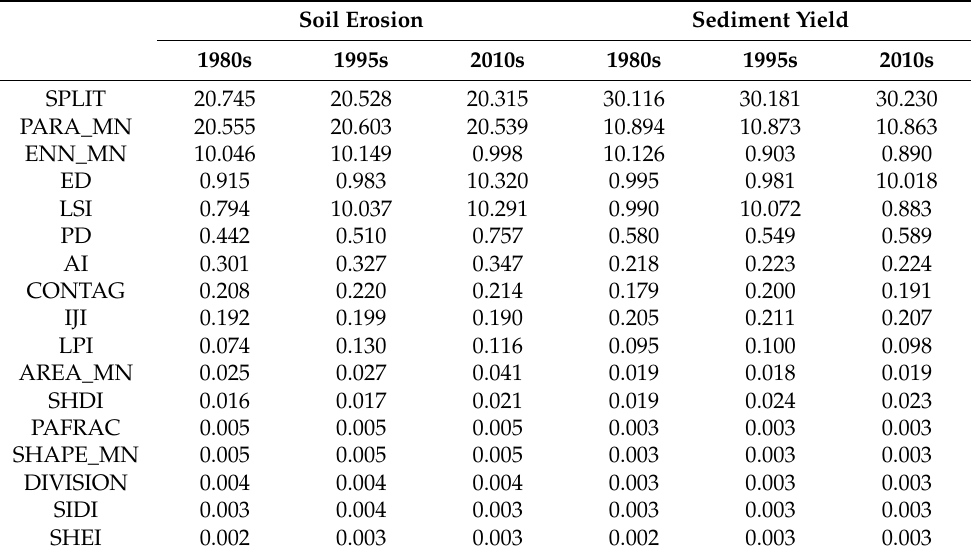
Table 8. The VIP of landscape metrics for soil erosion and sediment yield under Combination